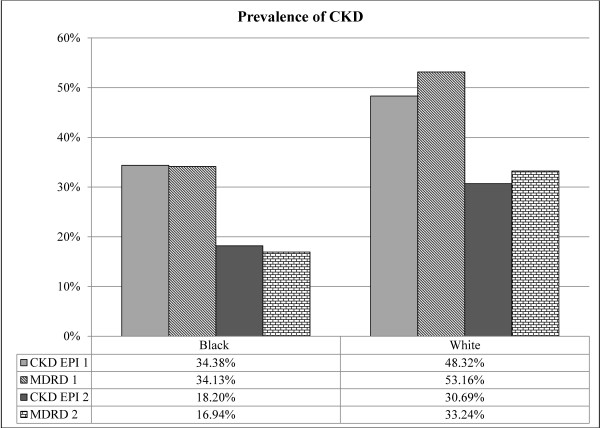
Unadjusted prevalence of CKD in the study population when only 1 serum creatinine versus 2 serum creatinine measurements is used in the MDRD or CKD-EPI equation. The prevalence of CKD is reduced by 40% when using 2 serum creatinines.